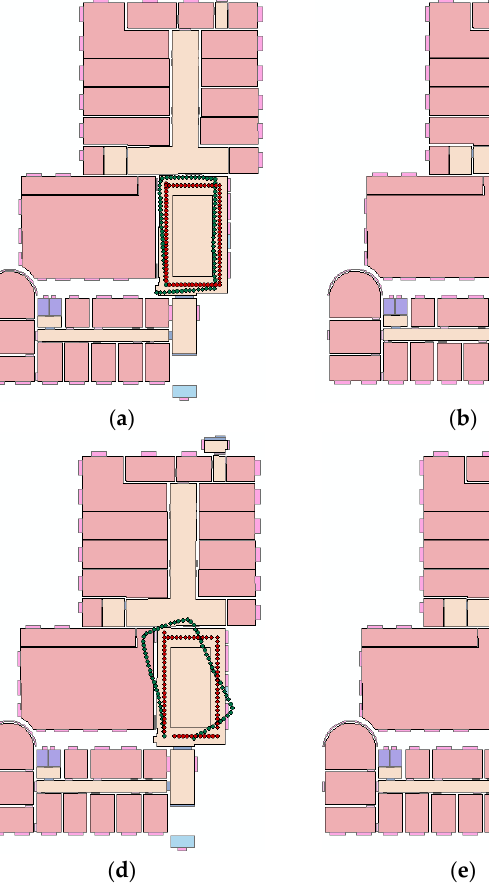
Figure 13. The route of six participants. Green indicates the PDR results and red shows the calibrated results. ( a ) F1(Zhou); ( b ) F2(Zhu); ( c ) M1(Guo); ( d ) M2(Ma); ( e ) M3(Liu); ( f ) M4(He). Table 4. The time of a single update step for a single particle in different indoor places (unit: ms). M1 M2 M3 M4 M5 M6 0.32 0.77 0.36 0.47 0.42 0.36